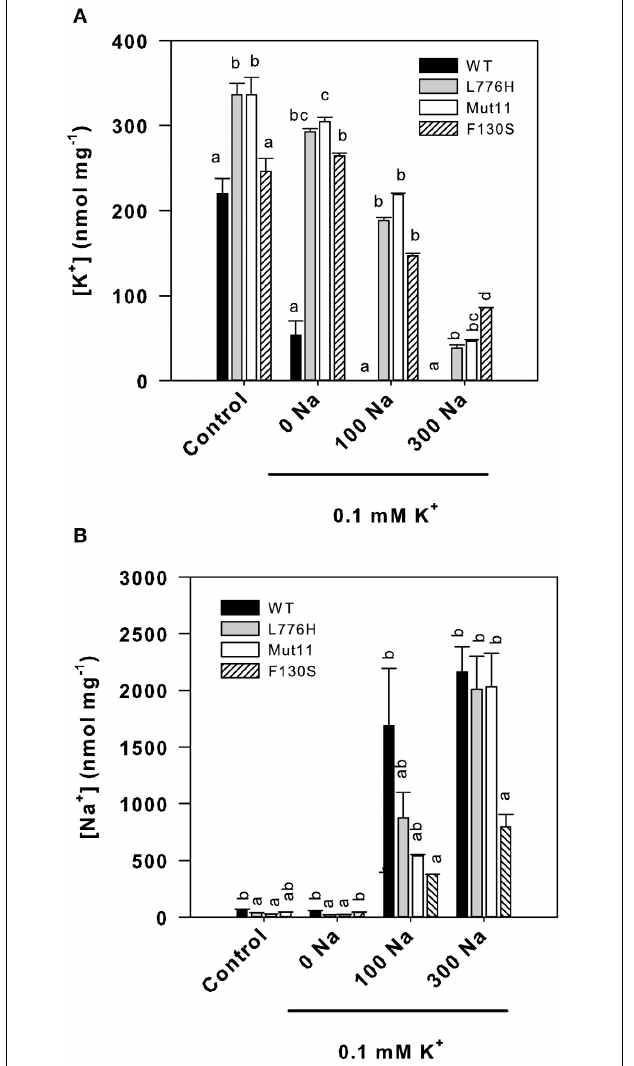
FIGURE 2 | Internal K + and Na + concentrations of 9.3 yeast cells expressing WT AtHAK5 and mutated AtHAK5 K + transporters. The same strains described in Figure 1 were grown for 24h in minimal AP liquid media supplemented with the indicated K + and Na + concentrations. The control medium contained 3mM K + . After 24h cells were collected by filtration and their ionic content was acid extracted. The K + and Na + concentrations in the acid extracts were determined by atomic emission spectrometry and the internal K + and Na + concentrations calculated on a dry weight basis. Shown are averages of internal K + (A) and Na + (B) concentrations of at least 6 replicates and error bars denote standard error. Columns with different letters within each ionic treatment are significantly different according to Tukey test ( p < 0 . 05).